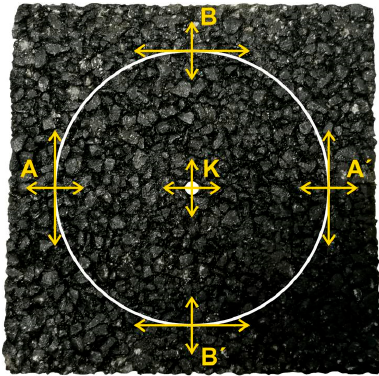
Figure 8. Slab points of the BPN measurements.